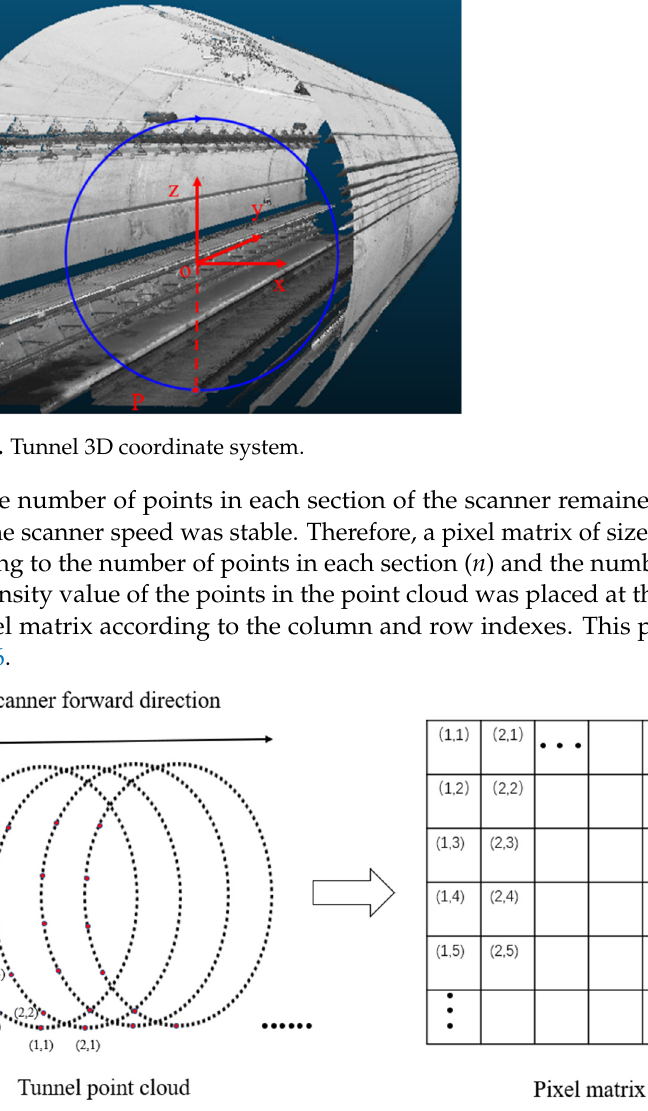
7 of 23 Figure 4. Different section types of mining tunnel: ( a ) horseshoe tunnel; ( b ) straight-wall circular arch tunnel; ( c ) similar rectangular tunnel A; ( d ) similar rectangular tunnel B.